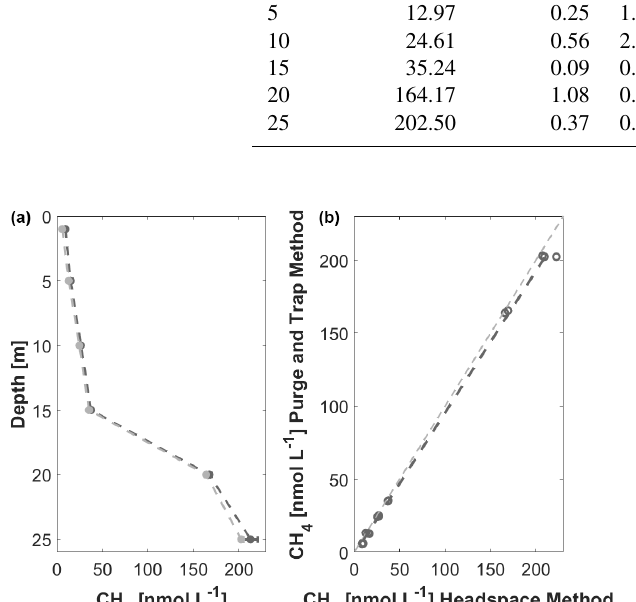
Figure 3. Boknis Eck depth profile of CH 4 measured with PT (light grey) and HS (dark grey) in April 2020 (a) . Means are shown as filled dots and the dashed line, and standard deviation is displayed as error bars in the respective colours. Linear regression of CH 4 concentrations measured with PT against HS for samples from Bok- nis Eck in April 2020 (b) . The light grey dashed line indicates the 1 : 1 relation. y =− 1 . 59 + 0 . 97 x . R 2 = 0.999; p< 0 .